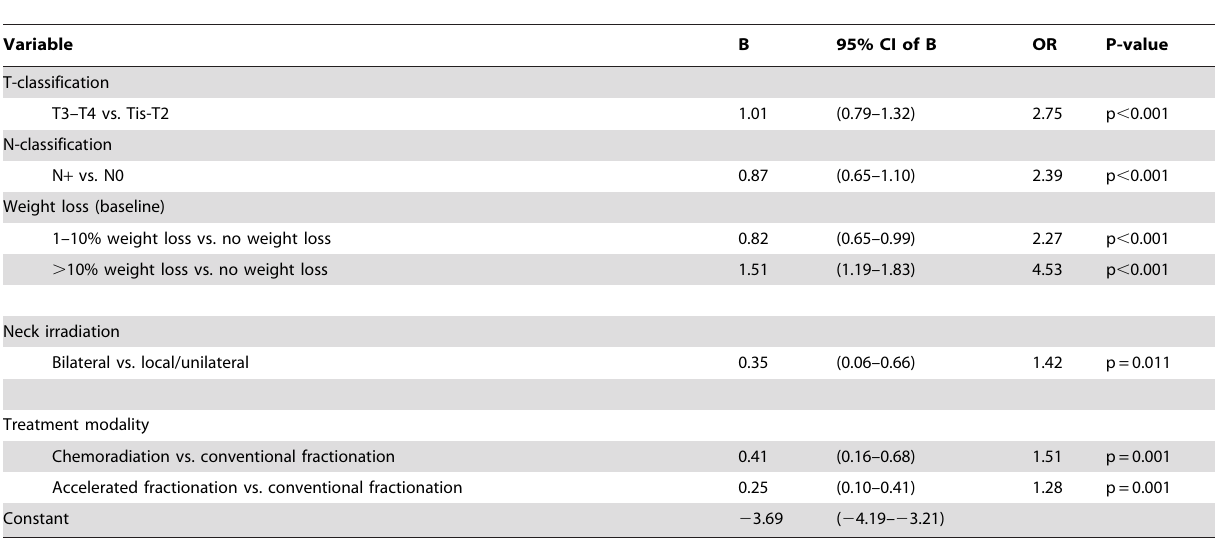
Table 3. Results of the LASSO analysis with tube feeding dependence at 6 months (TUBE M6 ) as primary endpoint.